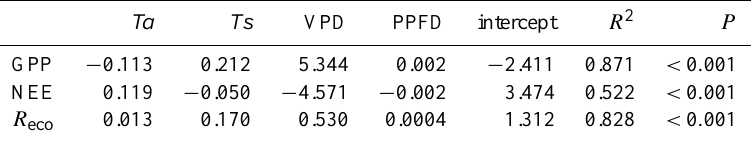
Table 6. The multi-factor regression analysis of CO 2 flux (GPP, NEE, R eco ) vs. Ta , Ts , PPFD, VPD, the data is on the annual base. Ta Ts VPD